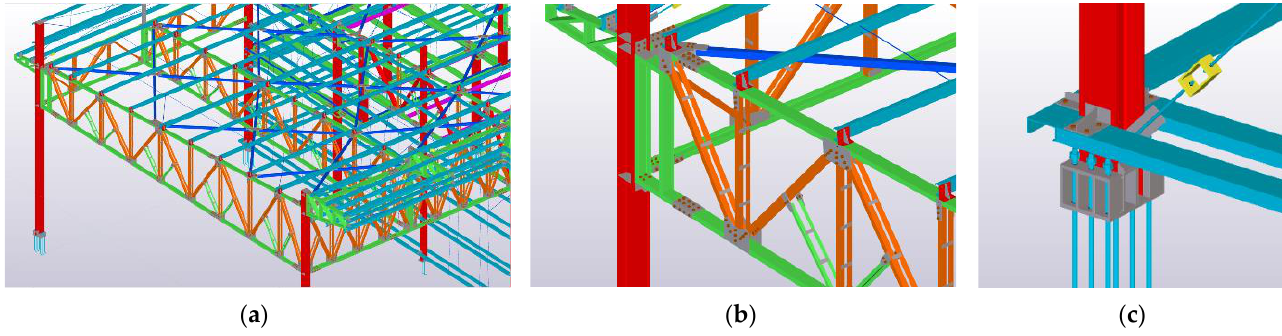
Figure 14. Steel BIM LOD 400 — Study sample. ( a ) Tekla Model LOD 400, ( b ) Miscellaneous LOD 400; ( c ) Steel Column LOD 400.